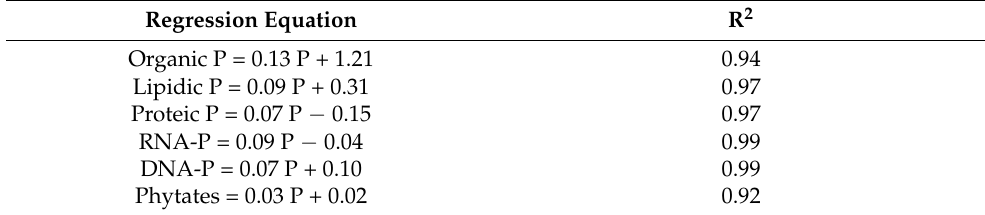
Table 5. Relationship between the different forms of P and the concentration of P supplied to the nutrient